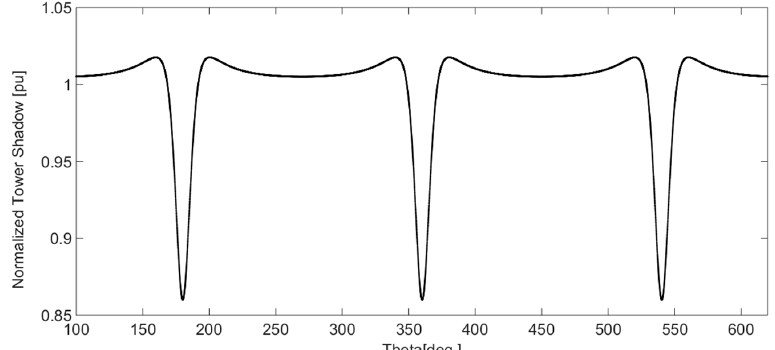
Figure 6. Tower shadow effect on each blade.